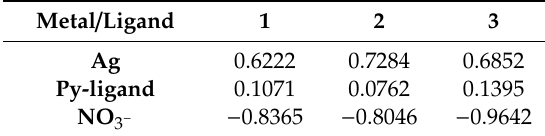
Table 1. The net natural charges at ligand groups and